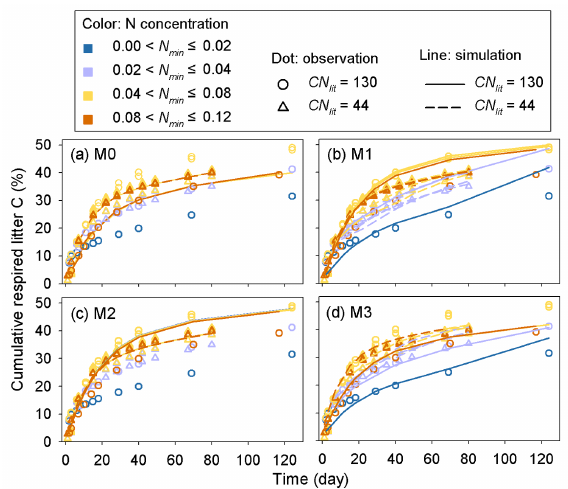
Figure 5. Time series of the simulated (lines) and observed (dots) cumulative respired litter C (% of initial litter C) at four different levels of soil mineral N availability (N min , gNkg − 1 soil). CN lit is the C:N ratio of plant litter. M0–M3 denote the four models tested in this study (Table 1). Here, the simulation results of each model were calculated with parameters optimized based on all of the 14 samples of incubation experiments (Table A2).